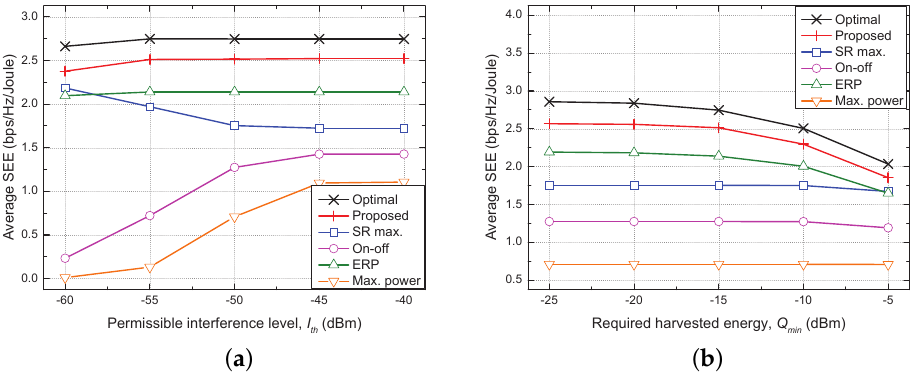
Figure 3. Comparison of performances of five considered schemes as a function of constraints of I th and Q min . ( a ) Average SEE vs. I th . ( b ) Average SEE vs. Q min